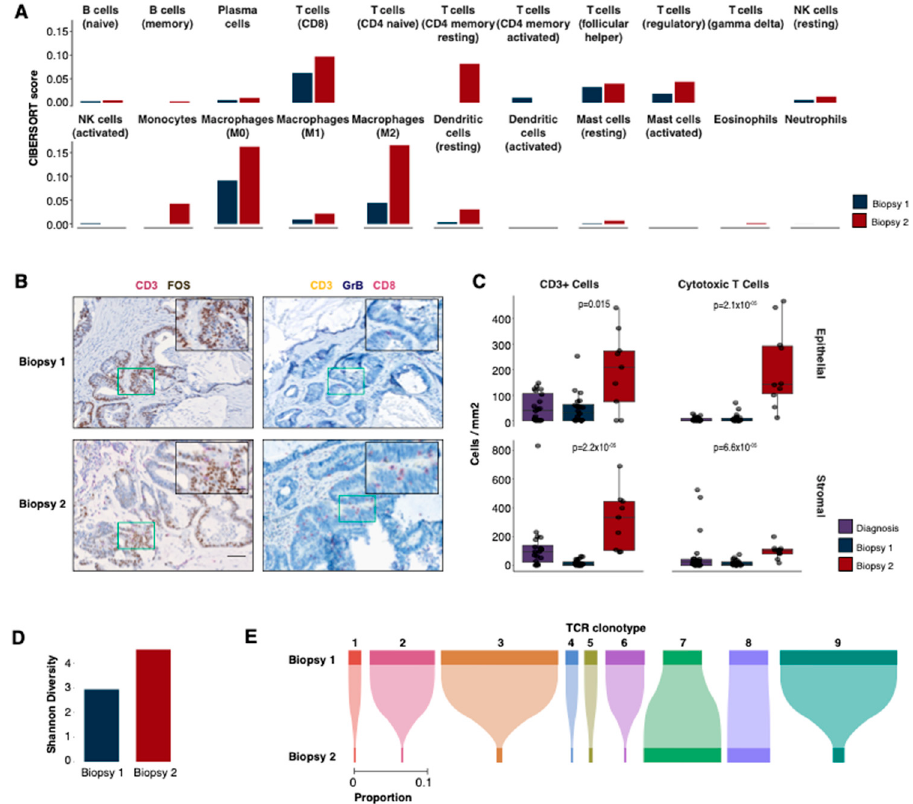
Figure 4. Immune profiles. ( A ) Immune deconvolution predictions for 22 immune cell types using CIBERSORT. ( B ) Immunohistochemistry (IHC) staining for two panels (CD3, FOS; CD3, GrB and CD8) in biopsies 1 (upper row) and 2 (bottom row). The colour stain for each protein is indicated in the label above each image. ( C ) IHC cell counts/mm 2 for different cell types in biopsies 1 and 2 and the diagnostic sample. The cell counts are reported separately for epithelial (top) and stromal (bottom) compartments. The p -values displayed are two-tailed Wilcoxon rank sum tests between the first and second biopsies. ( D ) The Shannon diversity of TCR β -chain repertoires for both biopsies. ( E ) The proportions of shared β -chain clones between biopsies 1 and 2.